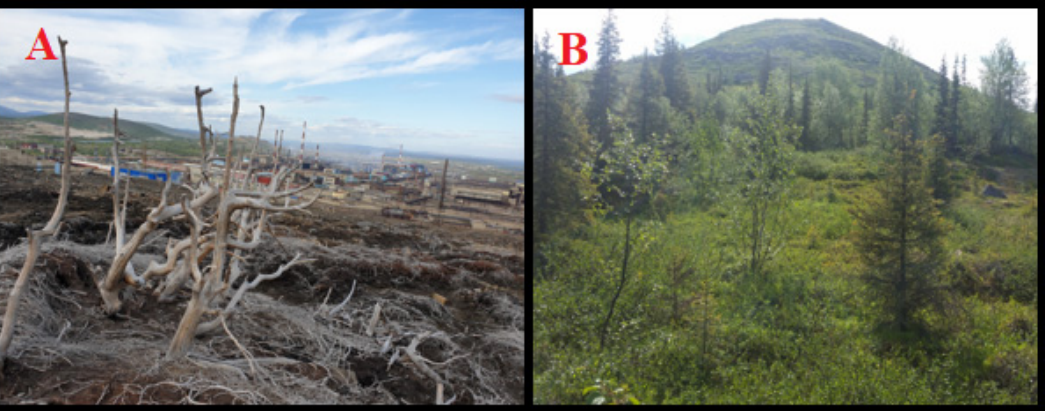
Figure 6. Examples of vegetation in the Monchepluton area: ( A )—destroyed forest in the Sopcha area; ( B )—forest–tundra in the Vurechuaivench area.